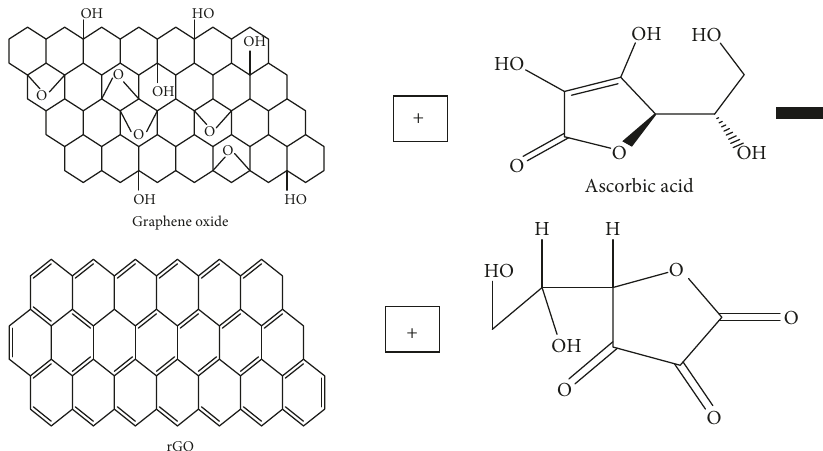
Scheme 3: Schematic representation of reduced graphene